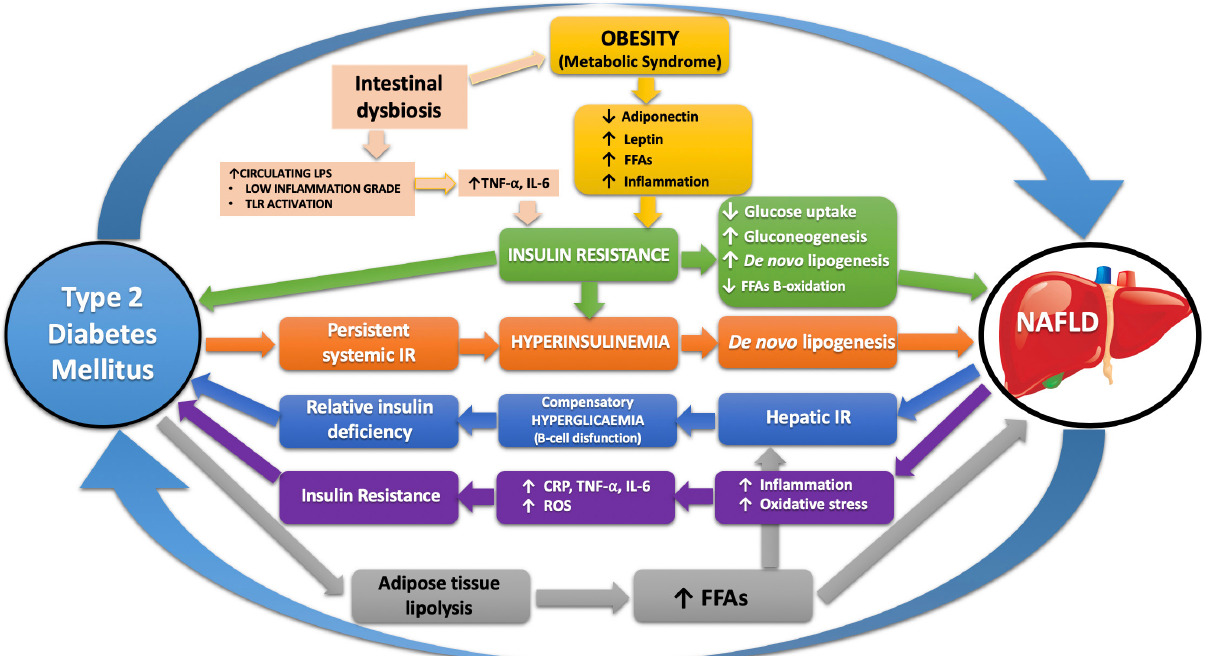
Figure 1. Schematic representation of the pathophysiological mechanisms shared between NAFLD and T2DM that connect the two sides of the coin. LPS: lipopolysaccharides; CRP: C reactive protein; TNF- reactive oxygen species; TLR: toll like